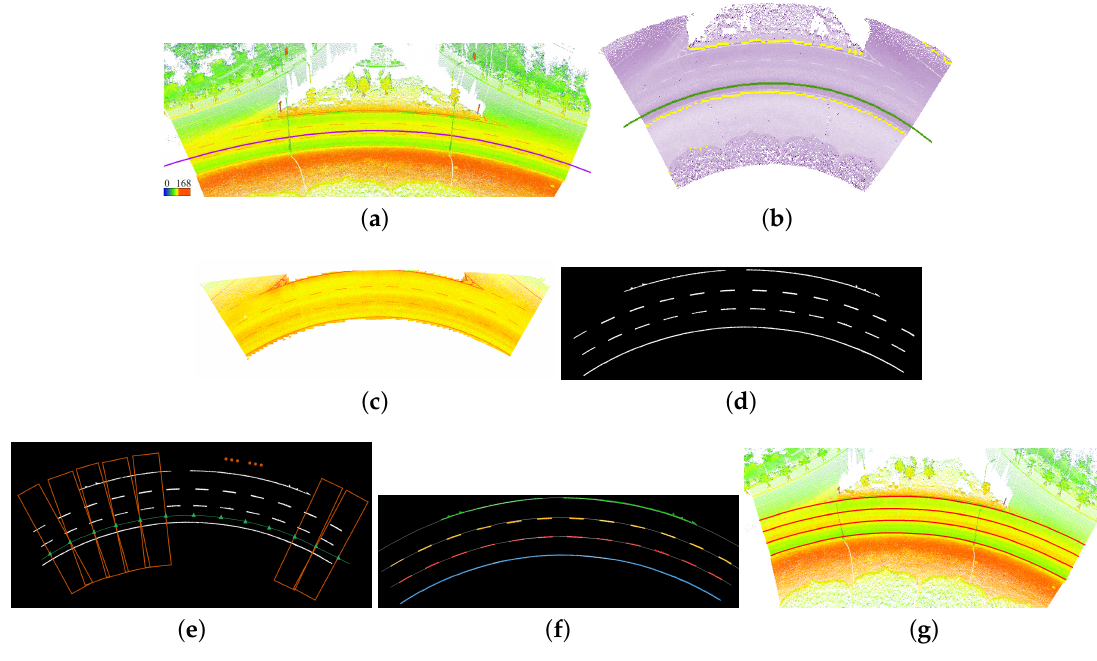
Figure 21. A roundabout road section. ( a ) The raw data. The purple line is the trajectory. ( b ) The road extraction. The yellow points are the curb grids and the green line is the trajectory. ( c ) The road points. ( d ) The binary image. ( e ) The process of clustering. The green triangles are the trajectory points and are connected sequentially to form line segments. Along the orange boxes that are perpendicular to each line segment, the deviation of every lane-marking pixel can be calculated. ( f ) The lane-marking pixels of each group are marked by a unique color, and the white lines are the lane lines fitted from those pixels. ( g ) The red 3D lane lines are presented in the colored point